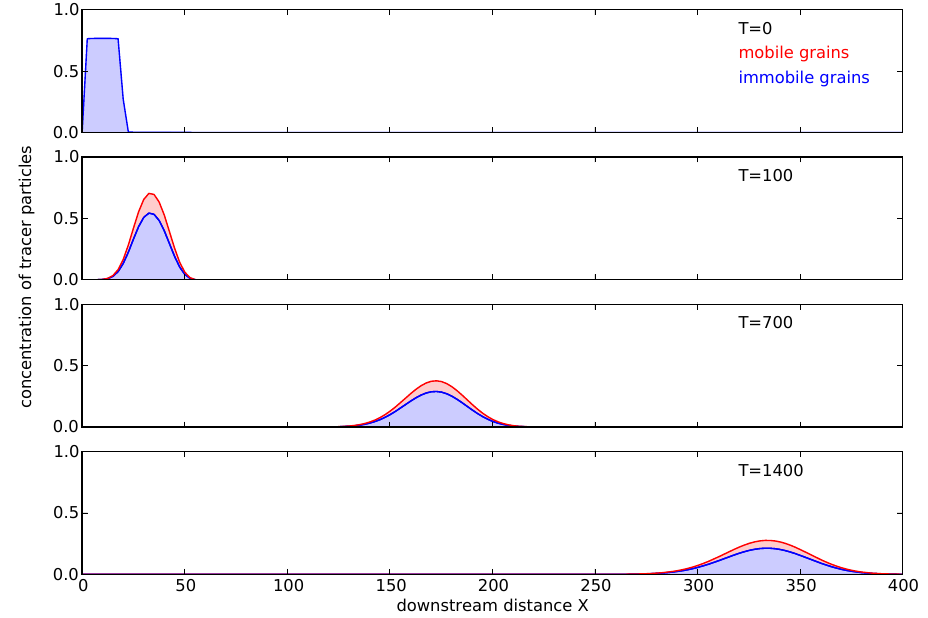
Fig. 2. Evolution of the concentration of tracer particles as a function of the dimensionless distance X , for α = 0 . 3. The initial shape of the plume is a step of marked grains on the bed surface of length 20.